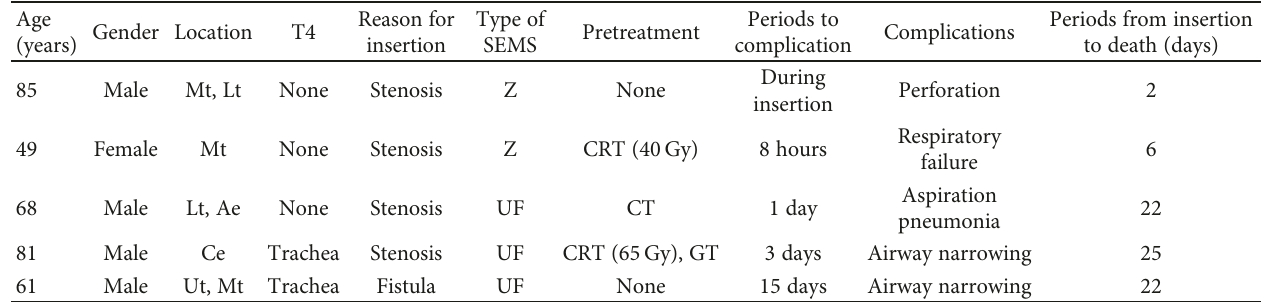
Table 8: Stent-related fatal cases.